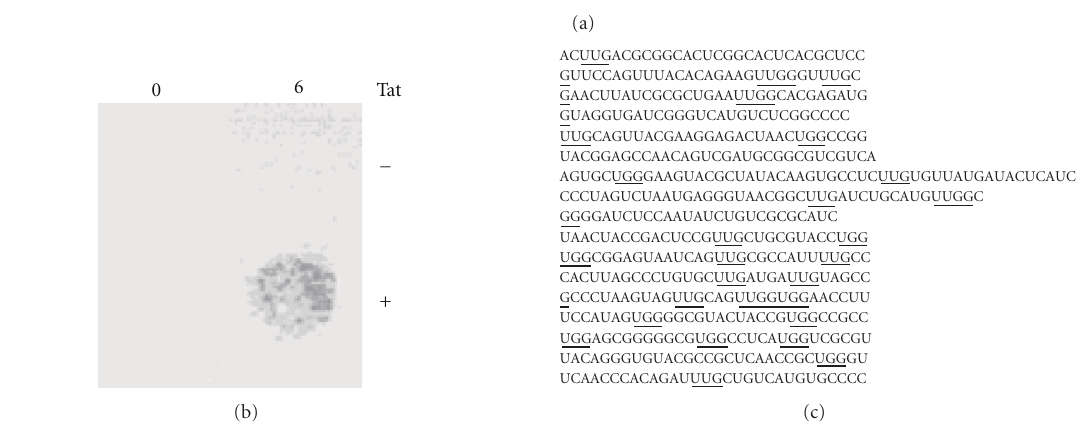
Table 1: Number and frequency of each triplet obtained from the primary sequences of the clones after the selection (a) . Second U C A G First Third U C U Number of triplet